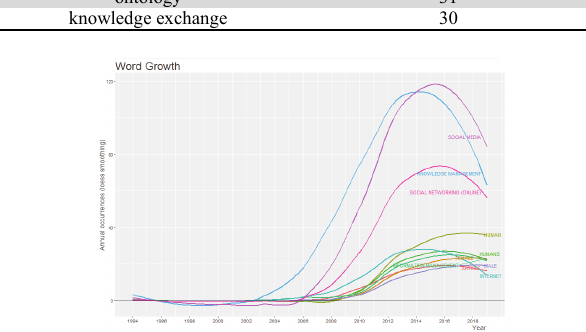
Word dynamics Fig. 3. Fig. 2. The frequency of the keywords used